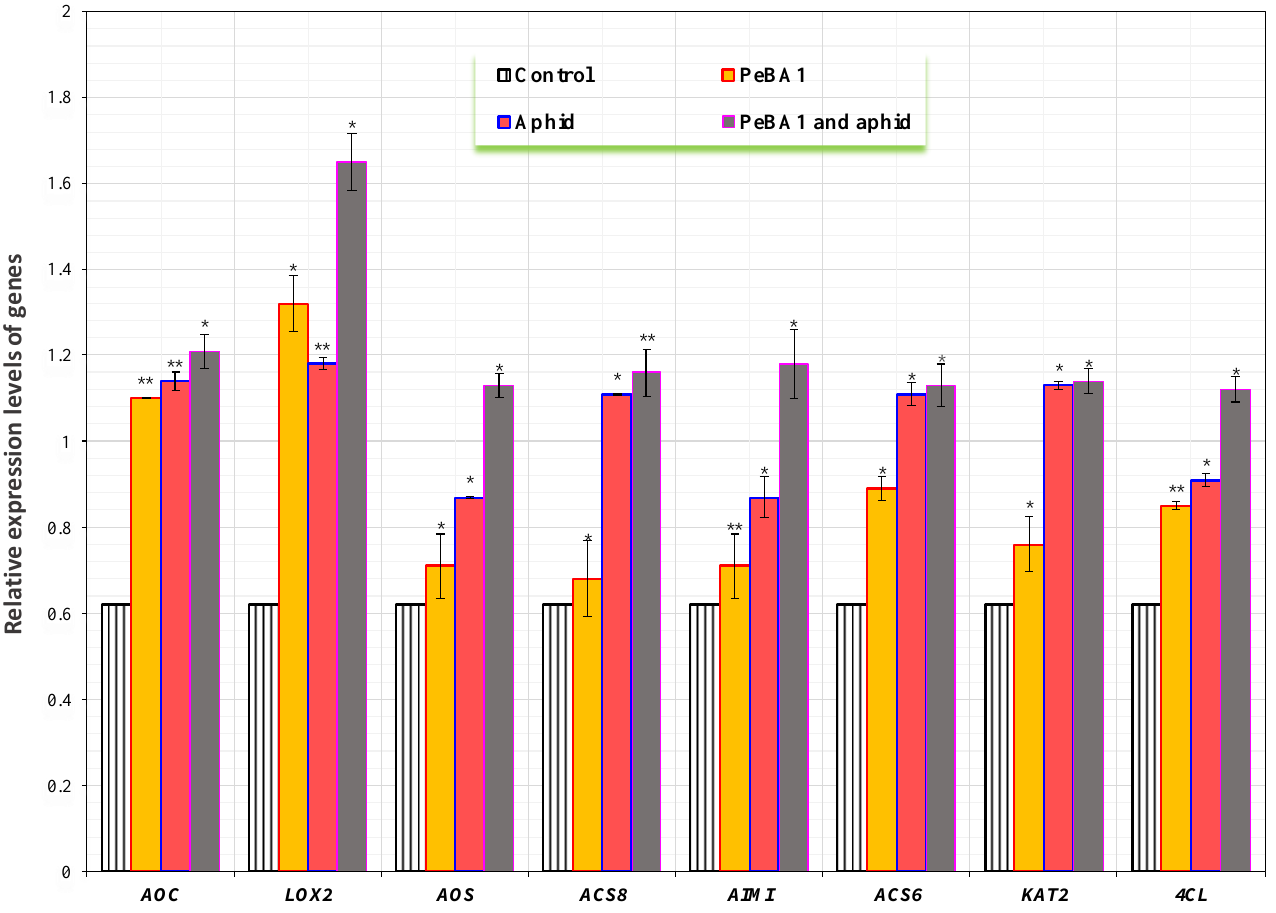
Figure 9. The relative expressions of plant defense from JA, SA, and ET pathway genes found after treatment with PeBA1-elicitor, PeBA1 and aphid, and aphid infestation. For each gene, an asterisk on the bar shows a significant difference from the buffer control as found by students t- test (* p < 0.05 and ** p < 0.01). Table 3. Log2 of fold change expressions all test genes involved in the JA, SA, and ET pathways after PeBA1 elicitor application, PeBA1 and aphid, and aphid infestation alone. Log 2 F c (Treated/Untreated)